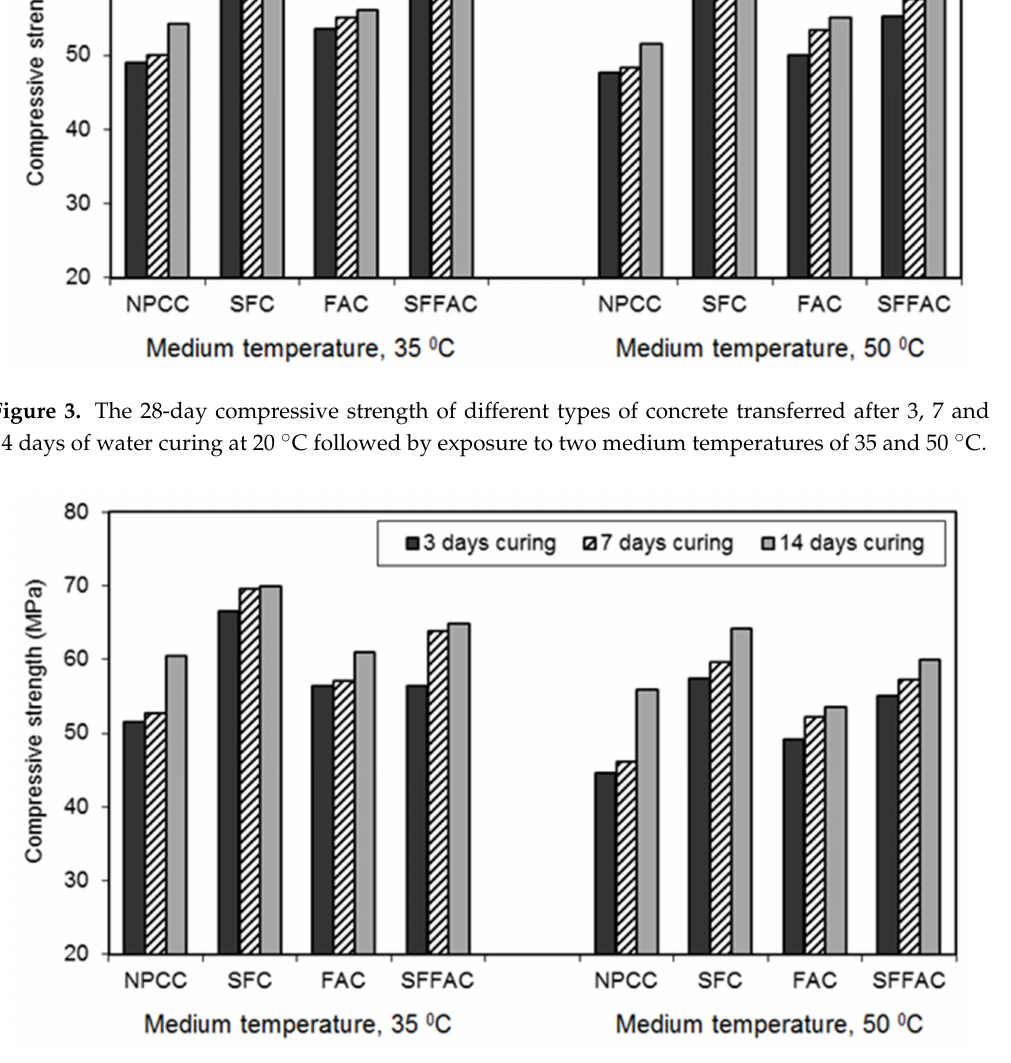
Figure 4. The 91-day compressive strength of different types of concrete transferred after 3, 7 and 14 days of water curing at 20 ˝ C followed by exposure to two medium temperatures of 35 and 50 ˝